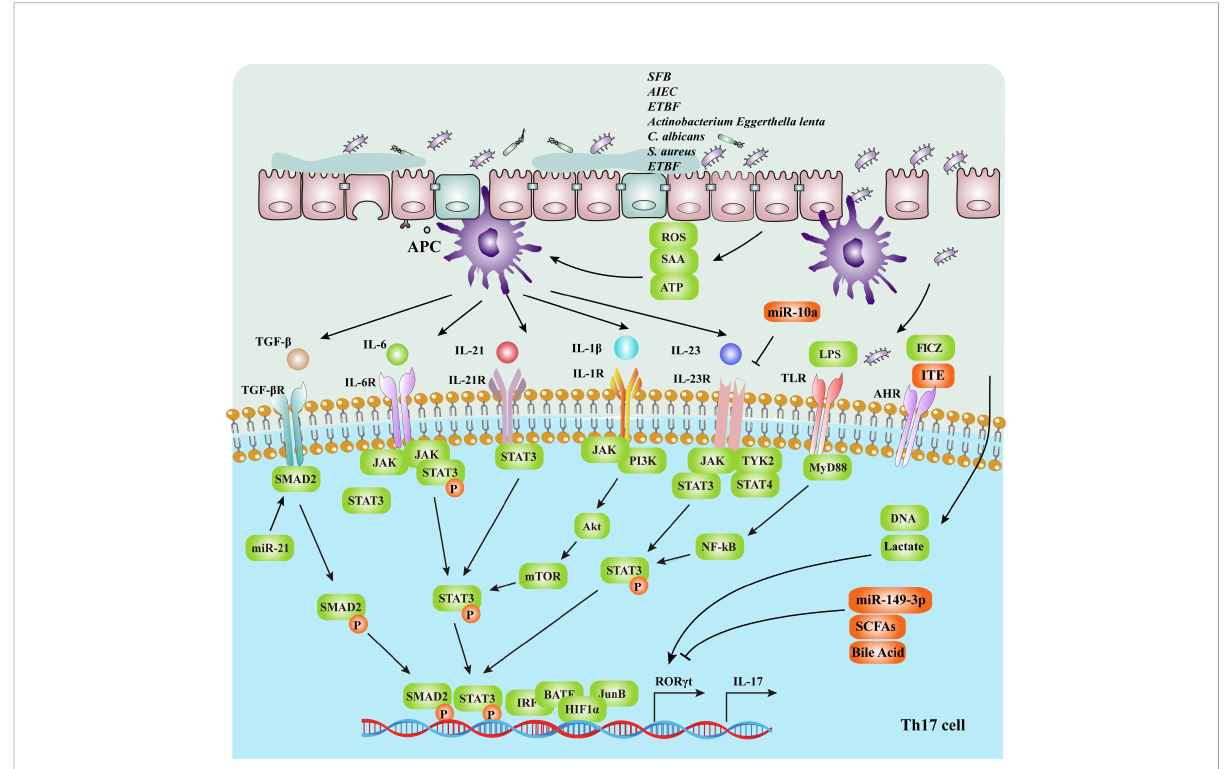
FIGURE 2 The intestinal mucosal microenvironment, composed of immune cells, cytokines, transcription factors and gut microbiota, regulates Th17 cell differentiation. The gut microbiota activates APCs and upregulates the expression of IL-6, IL-1 b and IL-23. IL-6, IL-22, TGF- b , IL-1 b and IL-23 can promote the differentiation of Th17 cells by upregulating the expression of the ROR g t gene, which depends on the STAT3 signaling pathway. ROR g t is a Th17 cell-speci fi c transcription factor that directly affects the differentiation of Th17 cells. In addition, The gut microbiota regulates the differentiation of CD4 + T cells through metabolites and energy metabolism, such as LPS, SCFAs and secondary bile acid. Upregulation of the transcription factors IRF4, BATF, HIF-1 and JunB promotes the expression of the ROR g t gene. Activation of the TLRs signaling pathways also promotes Th17 proliferation, thereby promoting naive T-cell differentiation into Th17 cells and IL-17 secretion. SFB, segmented fi lamentous bacteria; AIEC, adherent invasive Escherichia coli; ETBF, enterotoxigenic Bacteroides fragilis ; SCFAs, short-chain fatty acids; SAA, serum amyloid A; APCs, antigen-presenting cells; Th17, T helper 17 cells; ROR g t, retinoic acid receptor-related orphan nuclear receptor g t.